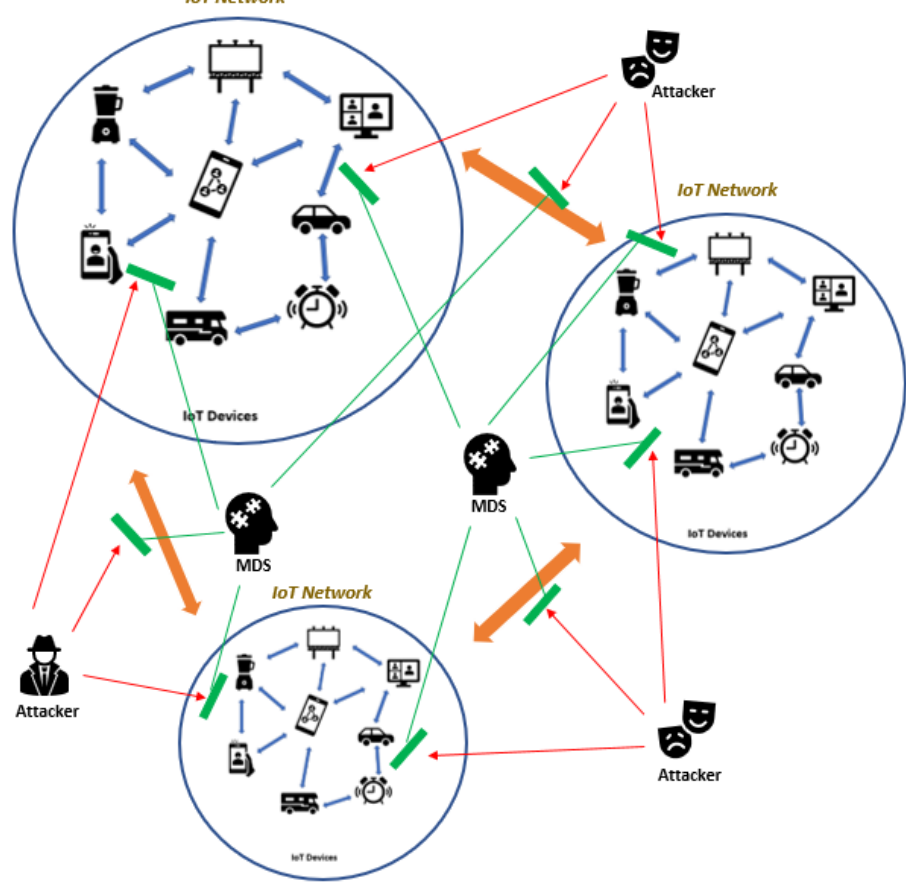
Figure 3. MDS in IoT systems.